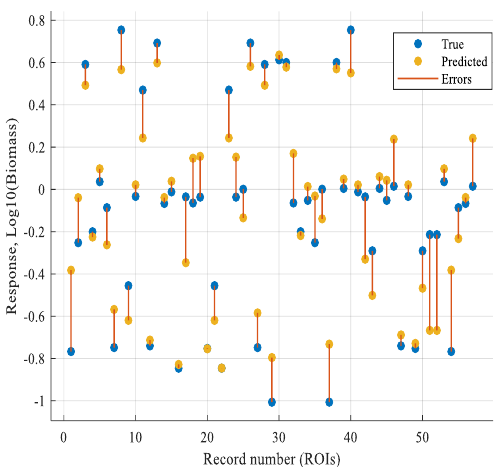
Figure 5 . Response plot of the MPRVI based biomass model in log scale.